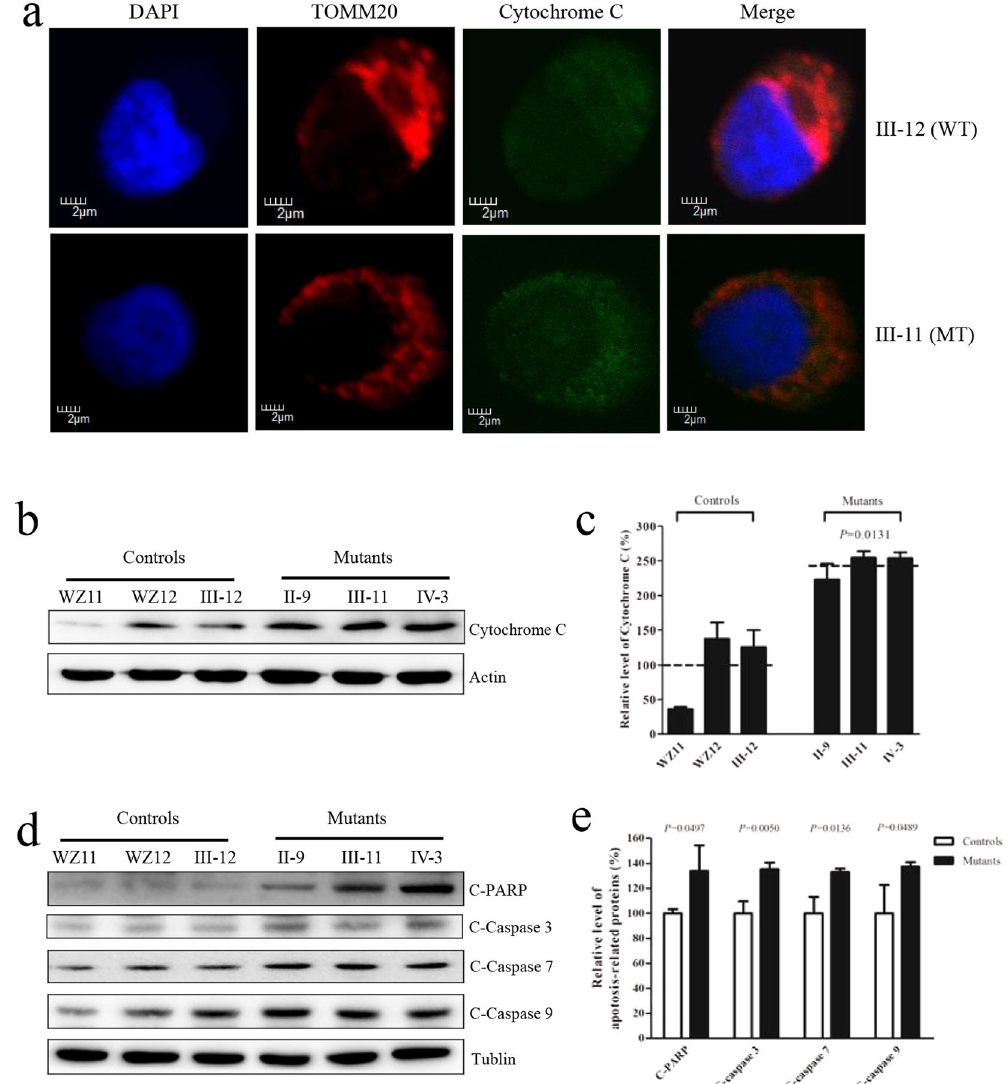
Figure 8. OPA1 mutation triggers apoptosis. ( a ) The distributions of cytochrome c from lymphoblastoid cell lines [patient III-11 and internal control III-12] were visualized by immunofluorescent labeling with an antimitochondrial TOM20 antibody conjugated to Alex Fluor 594 (red) and cytochrome c antibody conjugated to Alex Fluor 488 (green) was analyzed by confocal microscopy. DAPI-stained nuclei were identified by their blue fluorescence. ( b ) 20 μ g of total proteins from various cell lines were electrophoresed through a denaturing polyacrylamide gel, electroblotted and hybridized with cytochrome c with β -actin as a loading control. ( c ) Quantification of cytochrome c. The levels of cytochrome c in mutant and control cell lines were determined as described elsewhere 28 . The calculations were based on three independent determinations in each cell line. ( d ) 20 μ g of total proteins from various cell lines were electrophoresed through a denaturing polyacrylamide gel, electroblotted and hybridized with PARP, Caspases 3, 7 and 9 with Tublin as a loading control. ( e ) Quantification of four caspases. The levels of PARP, Caspases 3, 7 and 9 in mutant and control cell lines were determined as described elsewhere 28 . The calculations were based on three independent determinations in each cell line. Graph details and symbols are explained in the legend to Fig.